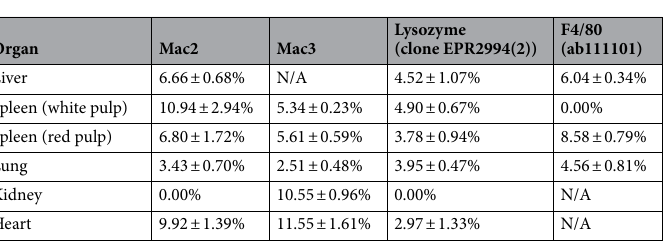
Figure 7. Specificity and staining patterns of macrophage markers during the phases of cardiac repair. CSF1R- EGFP reporter mice underwent non-reperfused myocardial infarction protocols. Dual immunofluorescent staining for GFP and macrophage antibodies (Mac2, Mac3, F4/80 ab111101, Lysozyme antibody clone EPR2994(2)) was performed to identify cardiac macrophages and to evaluate the sensitivity and specificity of various markers. Control (C) mouse hearts have a small population of CSF1R+ cells (arrows). Quantitative analysis shows that the density of CSF1R+ cells in the infarcted myocardium significantly increased after 24 h, and peaked after 7 days of permanent coronary occlusion. No significant increase in the density of CSF1R+ cells was noted in non-infarcted remodeling segments. ( A , B ) Although at the peak of the proliferative phase (7d), 99.6% of CSF1R+ cells were labeled with Mac2 (arrows), significant populations of CSF1R+ /Mac2- cells were noted during the inflammatory (24 h–3d) and maturation phase (28d) (arrowheads). ( C , D ) Mac3 also stained ~ 90% of CSF1R+ cells at the 7-day timepoint (arrows). However, during the inflammatory phase of cardiac repair (24 h-3d), many CSF1R+ /Mac3- cells were noted (arrowheads), and only ~ 40% of CSF1R+ cells were Mac3 positive. ( E , F ) On the other hand, LyzM staining was more sensitive during the inflammatory phase with 98.1% of CSF1R+ cells expressing LyzM at the 24 h timepoint (arrows). Significant populations of LyzM- negative CSF1R+ cells (arrowheads) emerged during the proliferative and maturation phase. G. F4/80 staining was absent in CSF1R+ cells (arrowheads) infiltrating the infarcted myocardium. (**p < 0.01, ***p < 0.001, ****p < 0.0001 vs. corresponding control, n = 4–5/group). Scale bar: 20 μm.